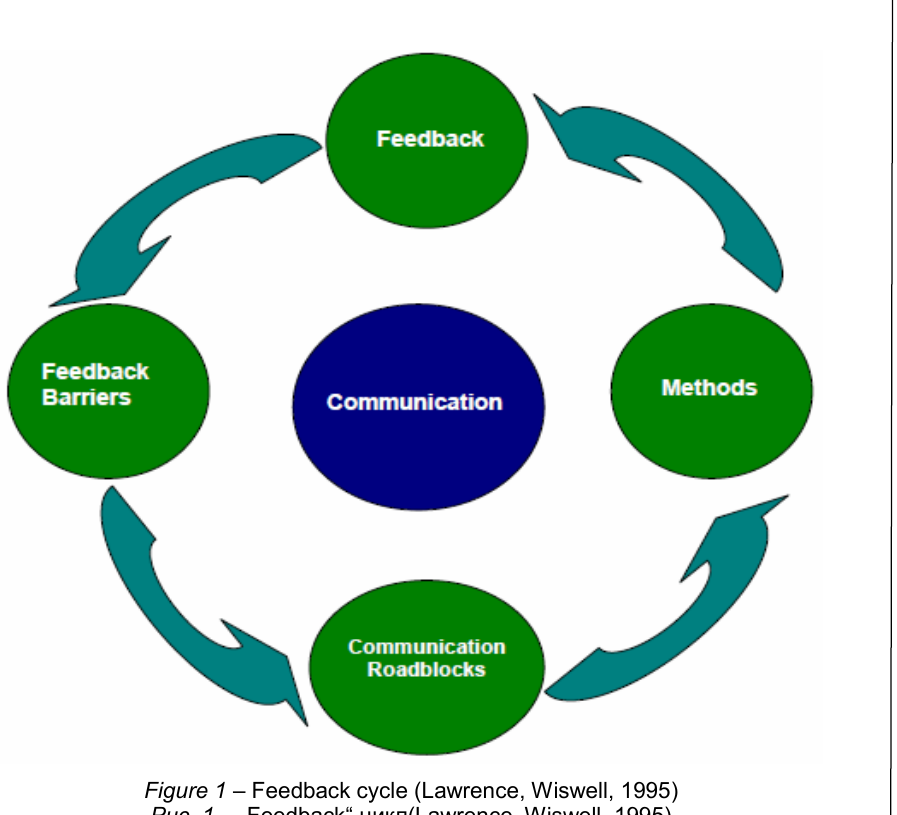
Figure 1 – Feedback cycle (Lawrence, Wiswell, 1995) Рис . 1 – „Feedback“ цикл (Lawrence, Wiswell, 1995) Slika 1 – „Feedback“ ciklus (Lawrence, Wiswell,